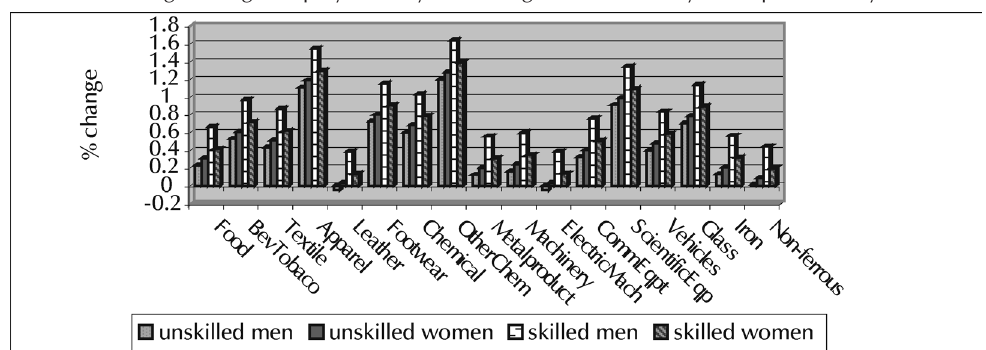
Percentage change employment by skill and gender: economy-wide productivity